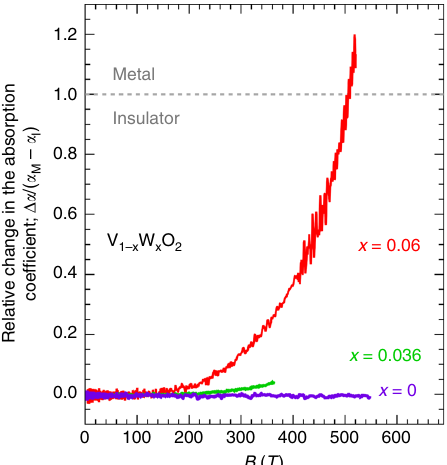
Fig. 6 Relative change in the absorption coef fi cient ( α ) at 1.977 μ m in V 1 − x W x O 2 ( x = 0, 0.036, 0.06). Δ α /( α M − α I ) is plotted as a function of magnetic fi eld. α M and α I are de fi ned as the α in the metallic and insulating phases at zero fi elds, respectively. Δ α is the magnetic- fi eld-induced change in the α . The ratio of the measurement temperature T to T MI for each fi lm is 35/295 ≈ 0.12 for VO 2 , 27/195 ≈ 0.14 for x = 0.036, and 14/100 = 0.14 for x =